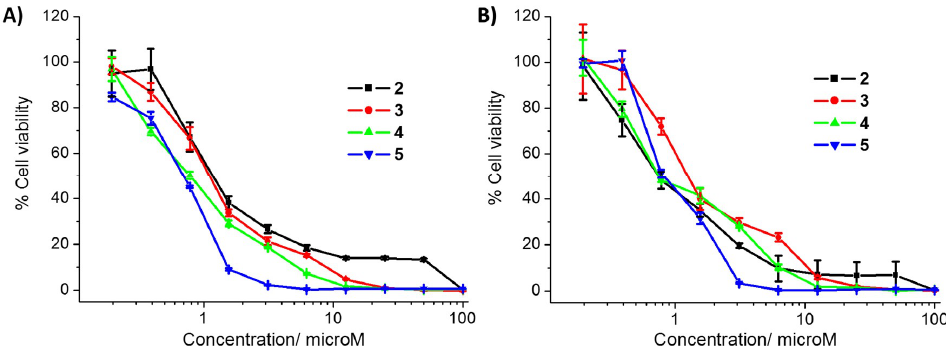
Figure 1. Compound concentration versus percentage cell viability plots for 2 – 5 against ( A ) bulk breast cancer cells (HMLER) and ( B ) breast CSC-like cells (HMLER-shEcad cells) (72 h incubation).